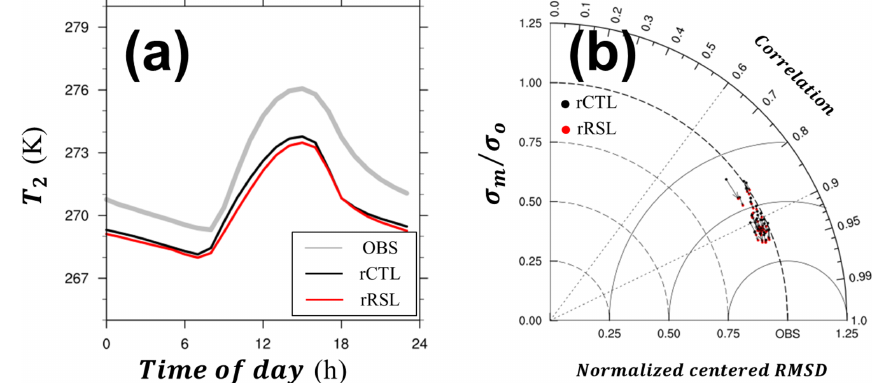
Figure 10. Same as in Fig. 9 but for the 2m temperature.